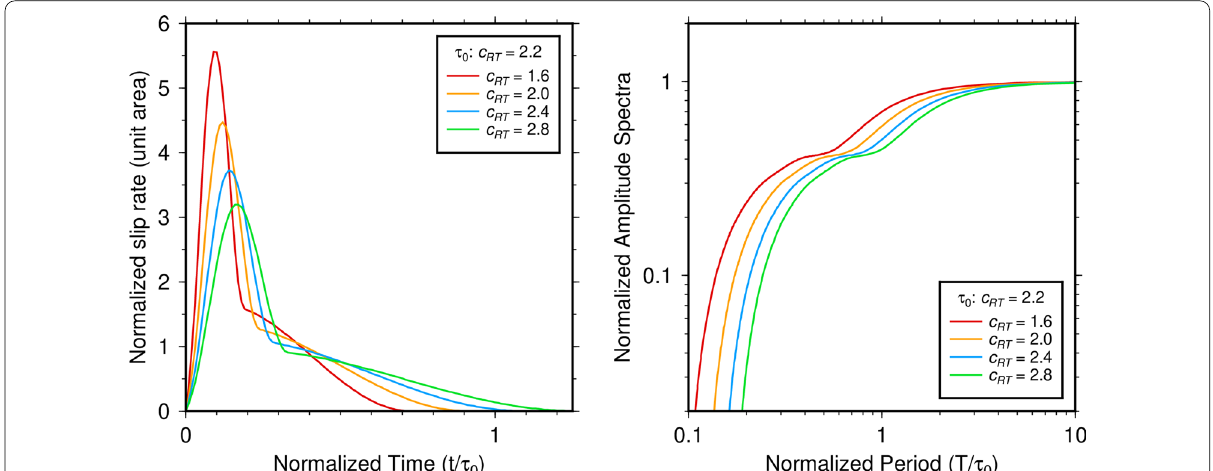
Fig. 4 Slip-rate functions corresponding to the four values of risetime coefficient ( c RT ) considered in this study. Left panel shows functions in the time domain and right panel shows their Fourier amplitude spectra. The amplitudes of the functions are normalized to have unit area, and the time and period axes are normalized by the risetime value of t 0 , which corresponds to c RT =